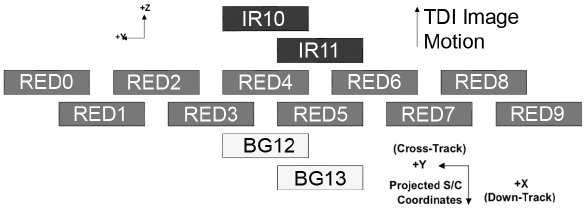
Figure 2. HiRISE focal plane layout schematic. Detectors are not shown to scale. The RED detectors are not perfectly aligned in each of two rows; instead some are slightly offset to mitigate aliasing at higher frequencies. The IR and BG detectors provide information at lower frequencies.